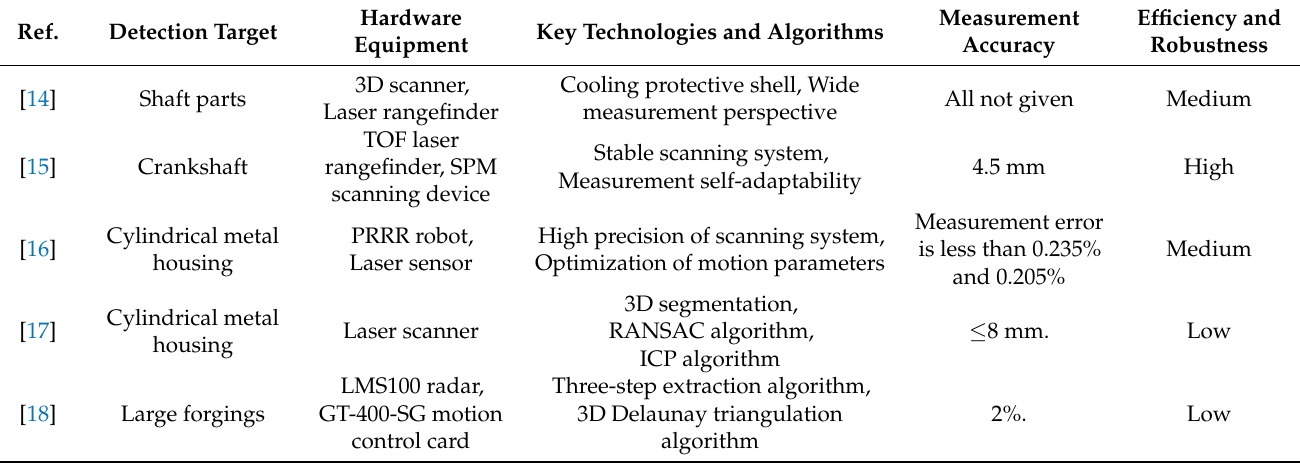
Table 1. Comparison of the actual application of TOF.